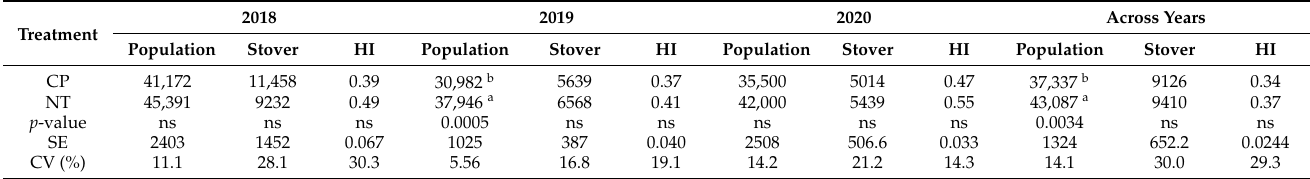
Table 2. Maize plant population (plants ha − 1 ), stover yield (kg ha − 1 ), and harvest index (HI) across sites used in 2018, 2019, 2020 and across seasons.